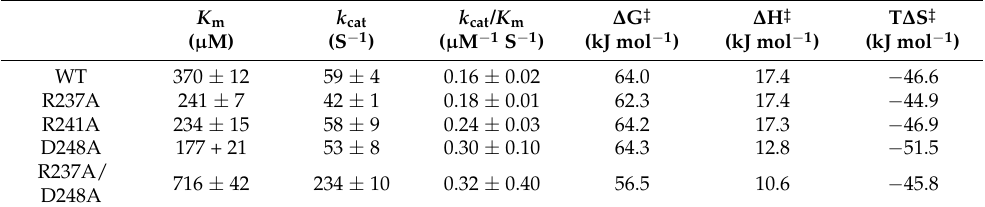
Table 3. Kinetic and thermodynamic parameters of WT and mutant PML enzymes.